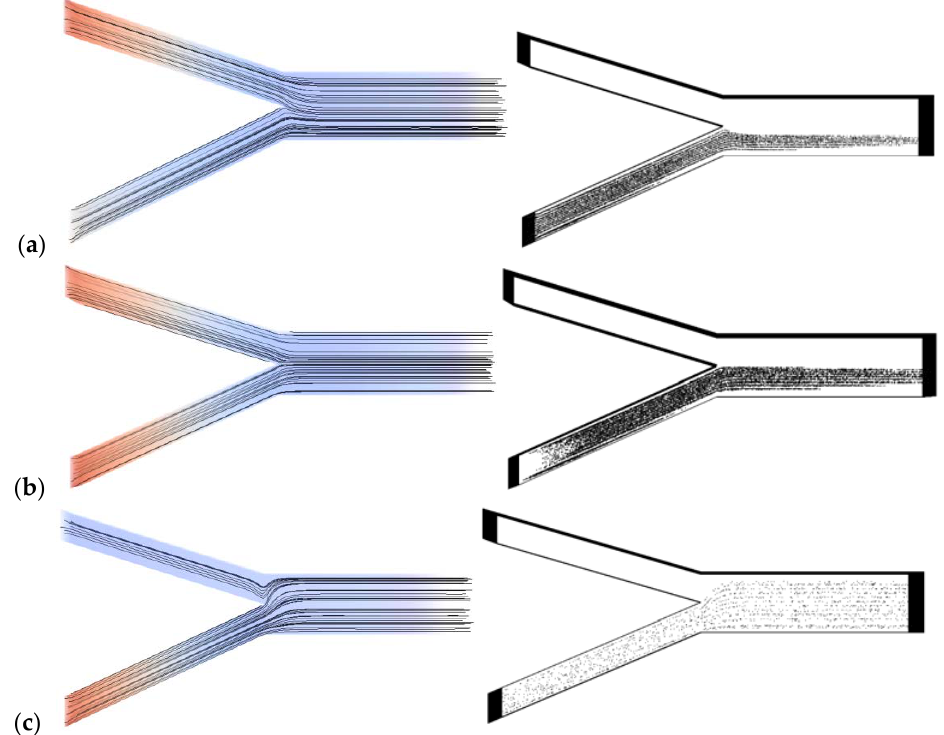
Figure 2. Streamlines ( left ) and snapshots of the particles positions ( right ) for θ = 30° and ( a ) Vc =